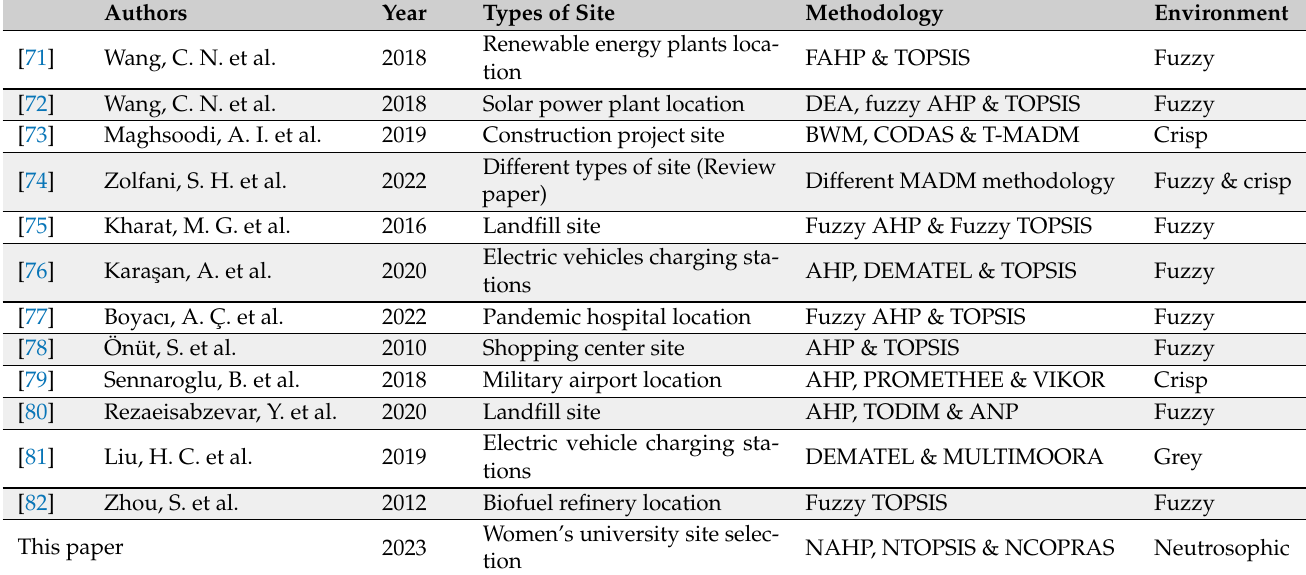
Table 3. Review of different type of site selection problems with solution